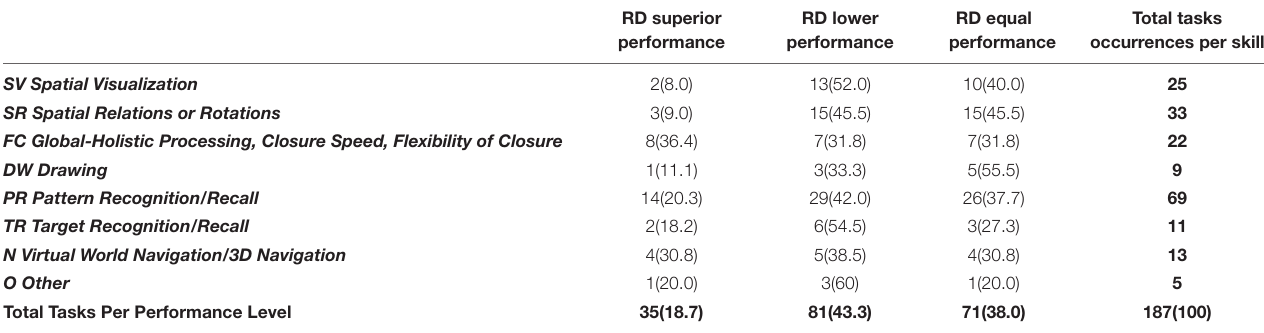
TABLE 2 | Summary of empirical research reports of raw scores or accuracy, and RT results of RD vs. controls performances on VS tasks over 40 years of